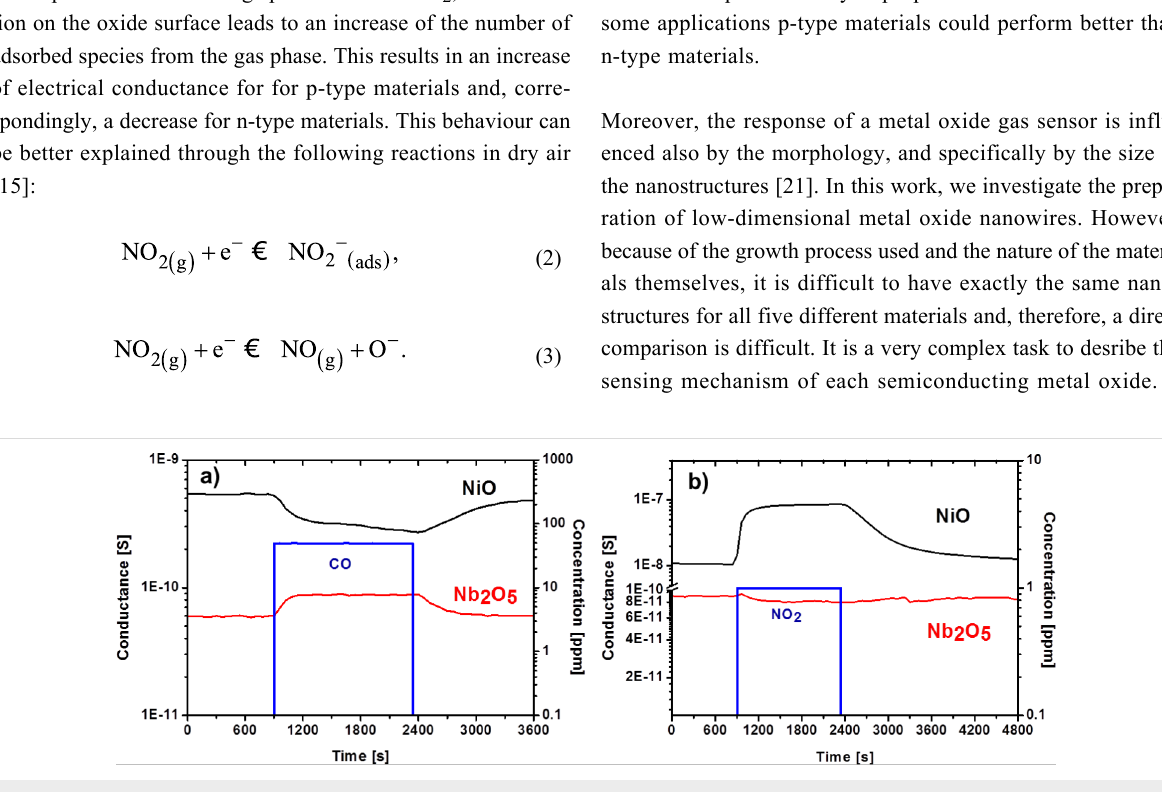
Figure 9: Dynamic response of NiO and Nb 2 O 5 sensing devices towards (a) (CO; 50 ppm, NiO (300 °C) and Nb 2 O 5 (400 °C)) and (b) (NO 2 ; 1 ppm, NiO (200 °C) and Nb 2 O 5 (400 °C)) measured at a relative humidity of 50% at 20